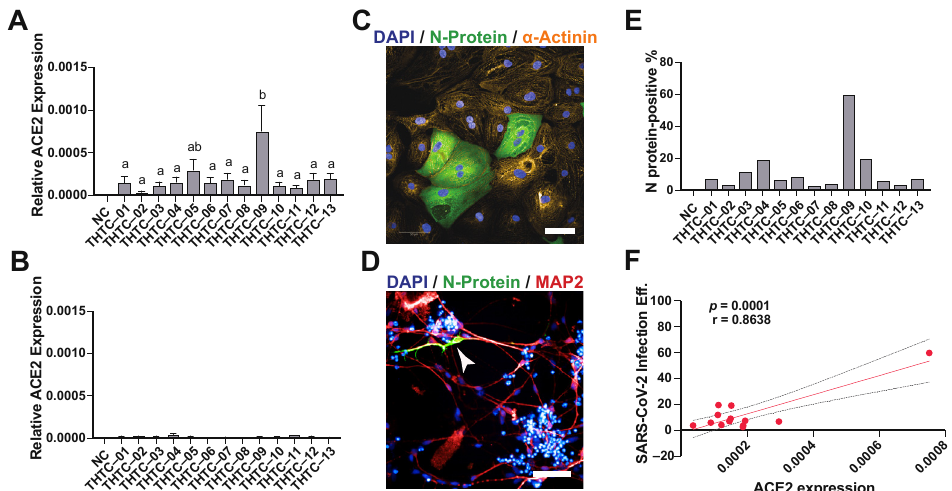
Figure 1. SARS–CoV–2 infects iPSC–cardiomyocytes but not neurons: ( A , B ) Quantification of ACE2–mRNA expression by RT–PCR in ( A ) hiPSC-derived cardiomyocytes and ( B ) neurons, n = 3; ( C , D ) a representative confocal image of cardiomyocytes ( C ) and neurons ( D ) infected with SARS-CoV-2. Cardiomyocyte scale bar: 50 µ m, Neuron scale bar: 20 µ m; ( E ) high–content quantification of SARS-CoV-2 infection efficiency in cardiomyocytes; ( F ) correlation between ACE2 expression and infection efficiency in cardiomyocytes. ( E ) Quantification of ACE2 expression by RT–PCR in hiPSC– derived neurons ( n = 3). ( F ) High–content immunocytochemical analysis of infected SARS–CoV–2 infected